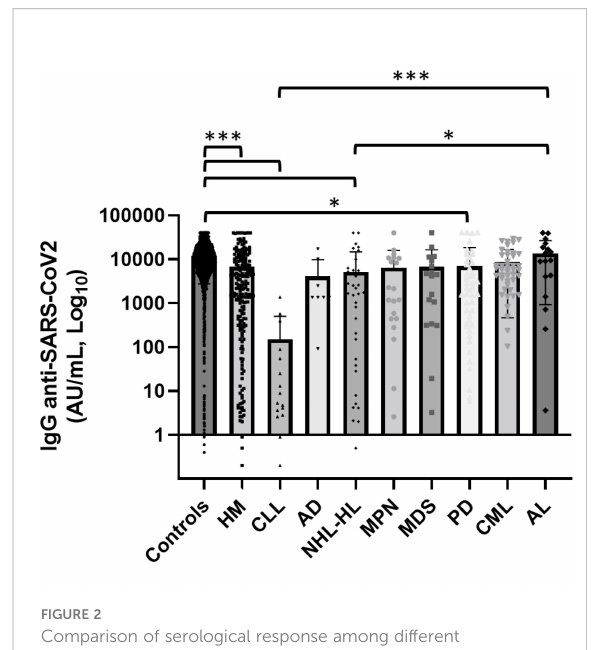
FIGURE 2 Comparison of serological response among different hematological malignancies and the comparator arm. HM, hematological malignancies; CLL, chronic lymphatic leukemia; AD, autoimmune disorder; NHL, non-Hodgkin lymphoma; HL, Hodgkin lymphoma; MPN, myeloproliferative neoplasm; MDS, myelodysplastic syndrome; PD, plasms cell disorder; CML, chronic myeloid leukemia; AL, acute leukemia; HSCT, hematopoietic stem cell transplantation. Hematological patients had a signi fi cantly lower level of anti-SARS-CoV-2 IgG than the control group (p < 0.001). CLL and lymphoma patients showed lower anti-SARS-CoV-2 IgG concentrations than AL patients (respectively p < 0.0001 and p = 0.008). Differences assessed by one-way ANOVA test (p < 0.001), Bonferroni post-hoc test: (*) p < 0.05; (**) p < 0.005; (***) p < 0.001. Error bars correspond to standard deviation calculated from the mean of relative concentrations. Values below black line were corresponding to anti-SARS-CoV-2 IgG lower than 10.0 AU/ml, and values of 0 AU/ml were not shown since the graph was on a log scale.